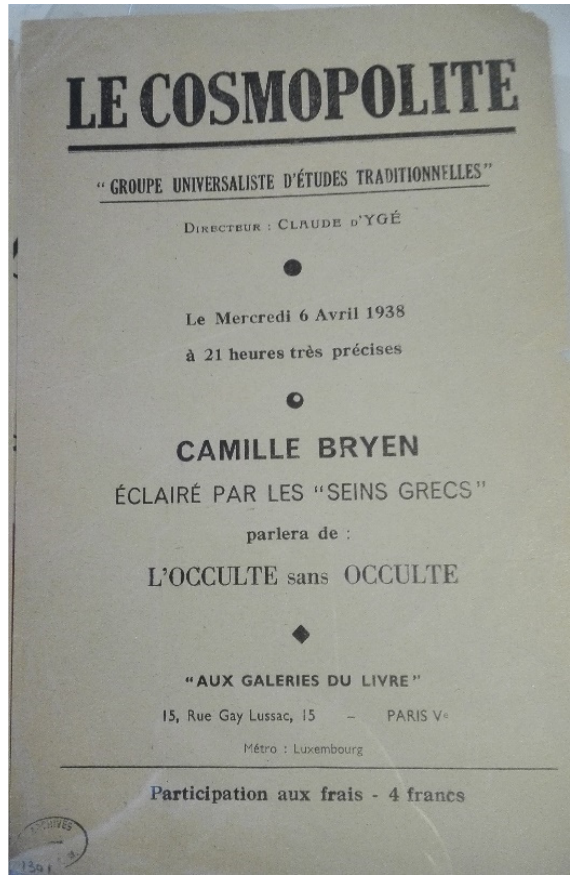
Figure 2. Poster for the conference “Camille Bryen, éclairé par les ‘seins grecs’, parlera de l’OCCULTE sans OCCULTE”, April 1938. Bryen Fund, Bibliothèque Kandinsky/Musée National d’Art Moderne/Centre Georges Pompidou, Paris. Copyright: ADAGP.